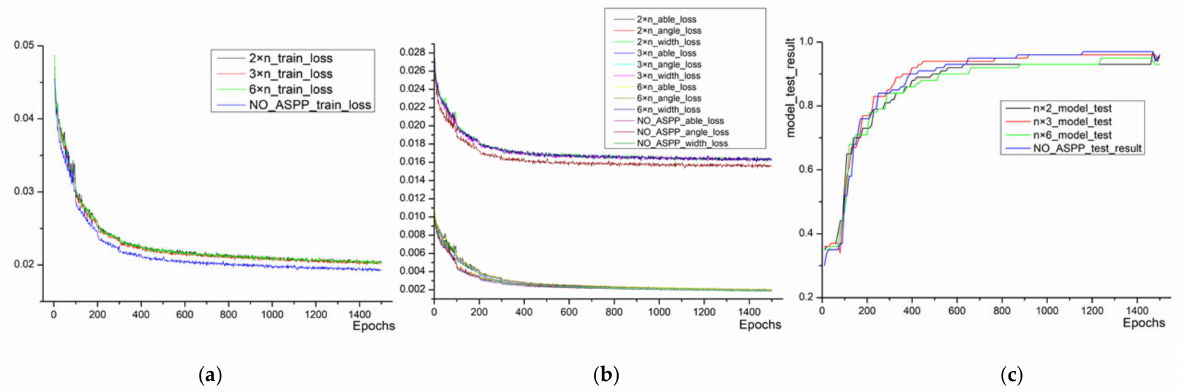
Figure 6. ( a ) The change process of the total loss value of different rates of ASPP; ( b ) the change process of the three sub-loss values of different rates of ASPP; ( c ) the training model test result in the training process of different rates of